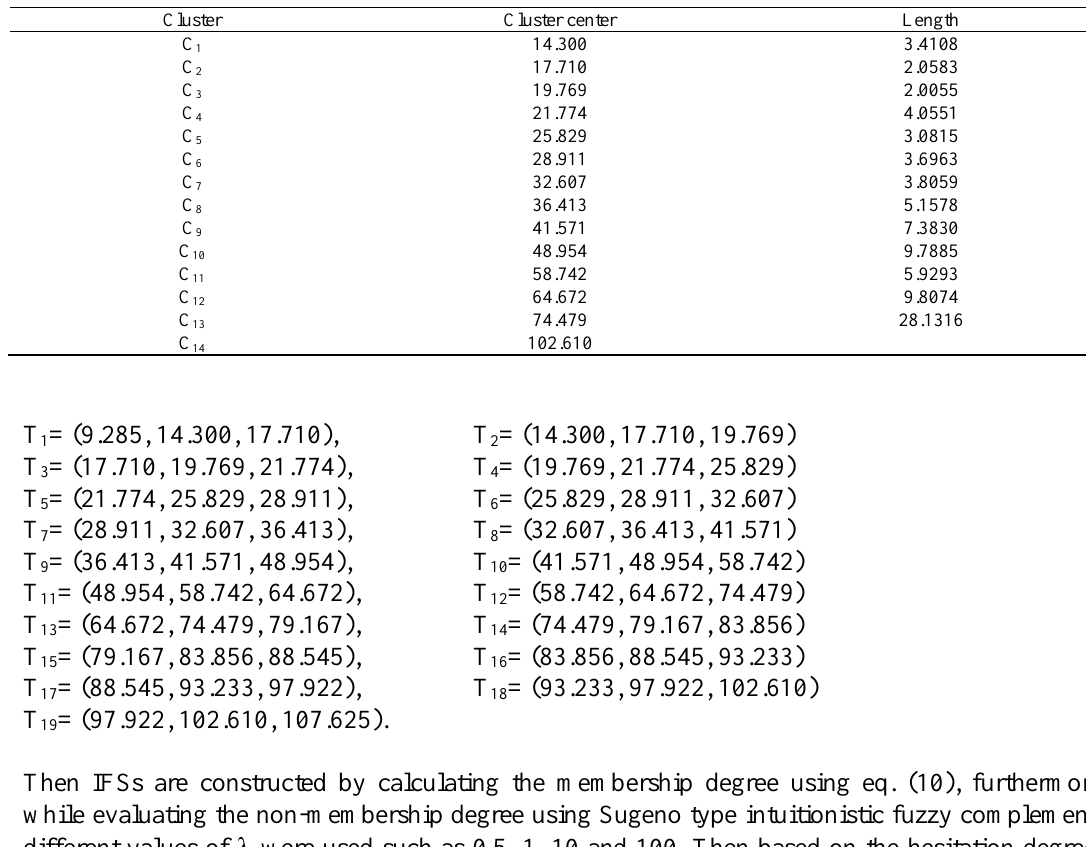
Table 1. List of cluster centers obtained using fuzzy c-means